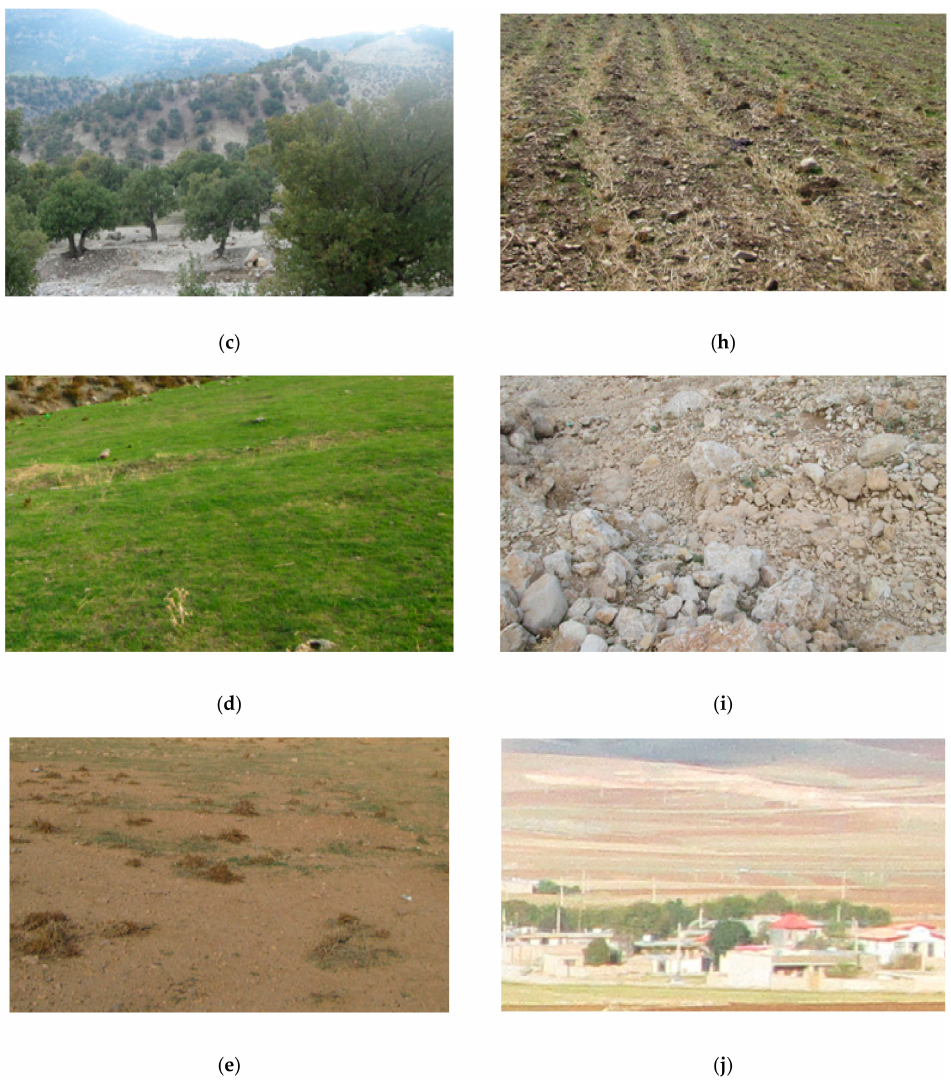
Figure 3. Di ff erent land covers in the field in the study area (Authors took all photos). ( a ) Dense forest. ( b ) Semi-dense forest. ( c ) Sparse forest. ( d ) Dense rangeland. ( e ) Sparse rangeland. ( f ) Garden. ( g ) Irrigated farmland. ( h ) Dry farmland. ( i ) Bare soil. ( j ) Urban